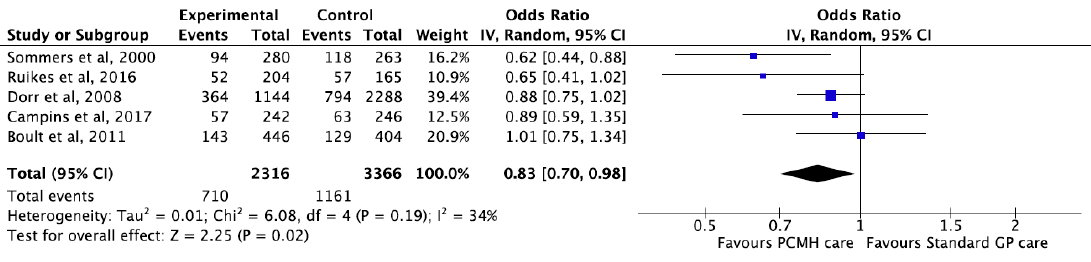
Figure 8. Forest plot for hospital admissions between PMCH care and Standard GP care.